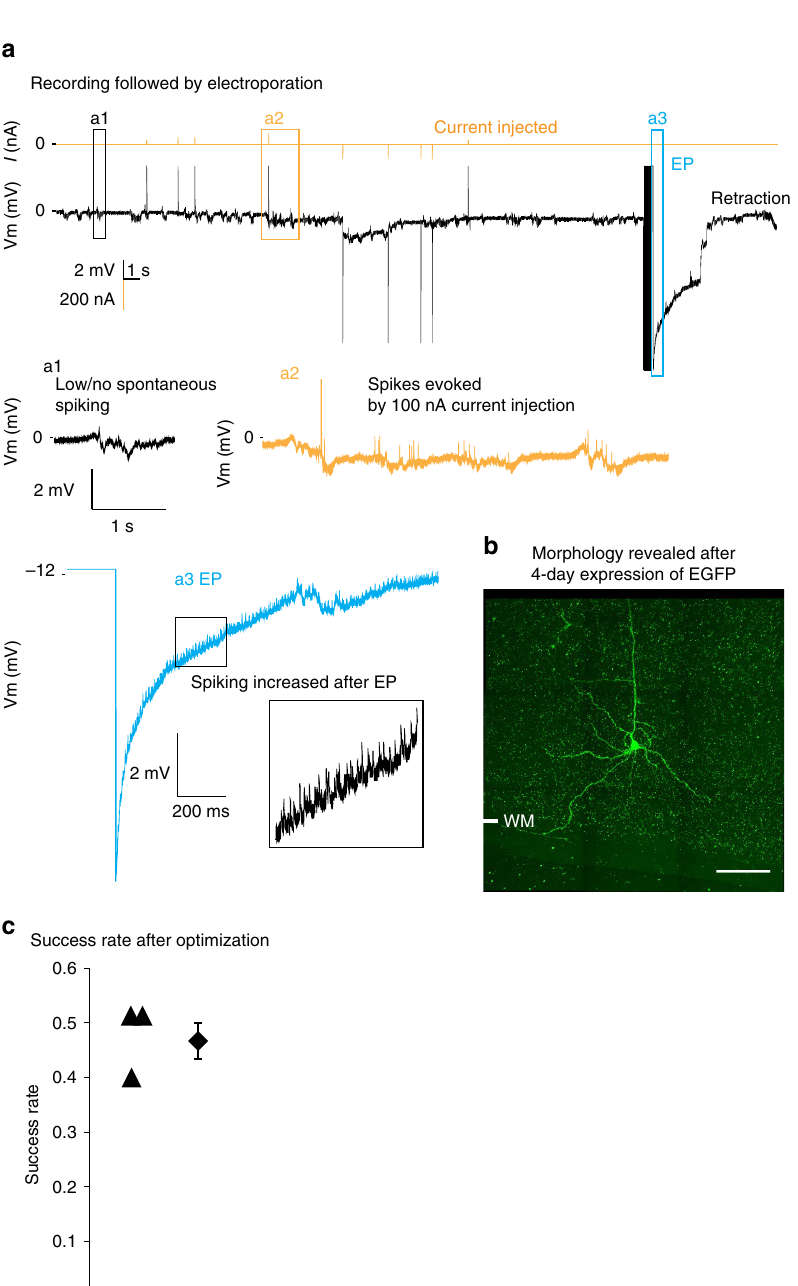
Figure 4 | Correlating morphology with in vivo electrophysiology at single-cell level with high efficiency. ( a ) Voltage trace of cell-attached recording of a neuron detected at a subpial depth of 768 m m. A threshould of 10% R p increase was used. (a1) This neuron was spontaneously inactive but voltage fluctuation was observed. (a2) Current injection (100nA) reversibly evoked spikes. (a3) Electroporation was conducted to deliver the EGFP plasmid into the neuron, increased spiking was observed after electroporation. ( b ) The neuron recorded was recovered in L6 of V1, showing morphological features of pyramidal neurons, which is consistent with the electrophysiological data. Montage of Z-projection images is shown here, note the pyramidal-shape soma and spiny dendrites. Image stacks were taken from the coronal section with a 63 (cid:3) , 1.4 NA oil-immersion objective. ( c ) Experiment yield is high across three mice tested. WM, white matter. Scale bar: 100 m the cell (which requires a smaller tip size) by using pipettes with R p ¼ 3–6 M O . To prevent post-electroporation cytolysis, electroporation voltage was also lowered so that the trans- membrane current is approximately between 1–1.5 m A (ref. 32), which is estimated to achieve the dielectric voltage drop across the cytoplasmic membrane. Intermediate concentration of DNA plasmid (0.1–0.2 m g per m l) was used to improve the delivery efficiency.